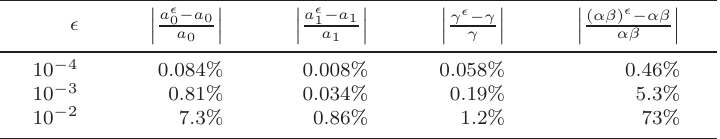
= 1 , γ = 10 − 4 , αβ = 10 − 5 (strong 1